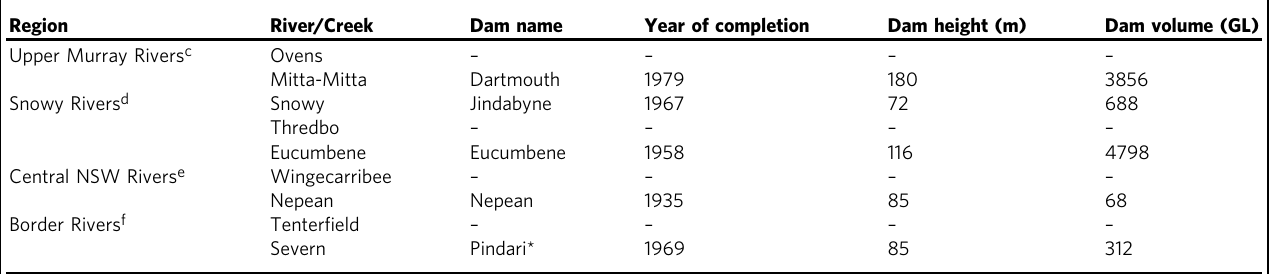
See Fig. 1 for details of geography. The letters c, d, e and f refer to panels in Fig. 1. GL gigalitres. *Pindari Dam. The height of the dam wall was doubled from 45m to 85m in 1995.